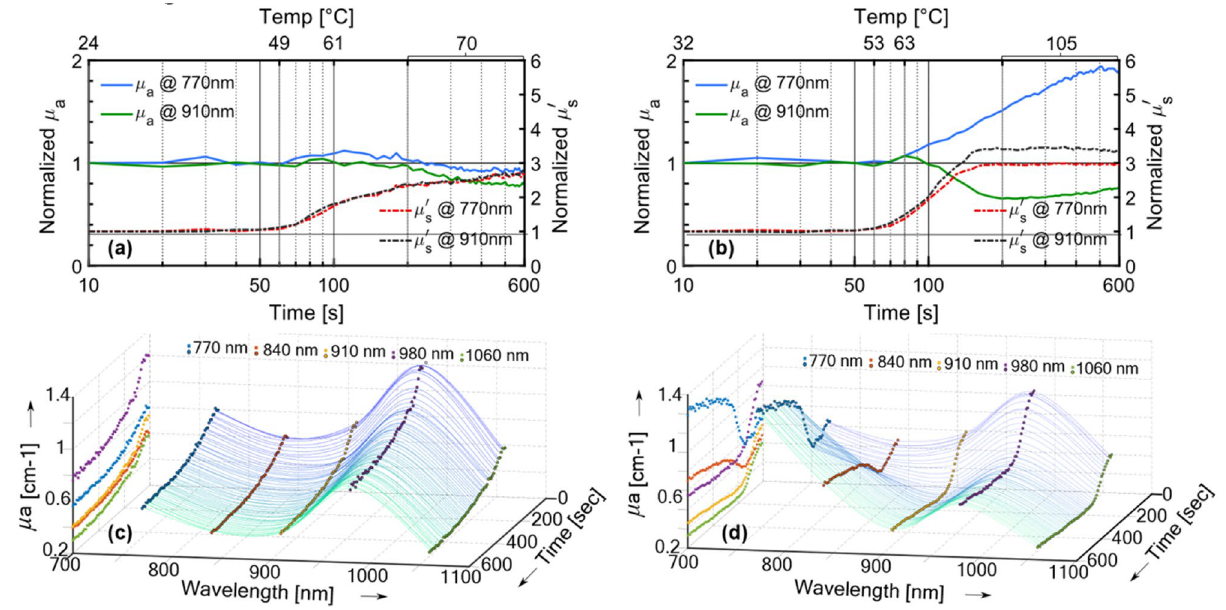
Figure 4. Time evolution of the optical properties at the five selected wavelengths with RF treatment in ex-vivo bovine heart tissue—( a , b ) temporal evolution of absorption and reduced scattering coefficients ( μ a and μ ʹ s ) at two wavelengths (770 and 910 nm) at treatment temperatures of 70 °C and 105 °C respectively. ( c , d ) Temporal evolution of μ a over all the five wavelengths (770, 840, 910, 980 and 1060 nm) for the two treatment temperatures 70 °C and 105 °C respectively. To provide the pseudo-spectral impression, interpolation is used with the five-wavelength information. The time vs. the absorption coefficient for the five wavelengths is projected on 2D plot on the